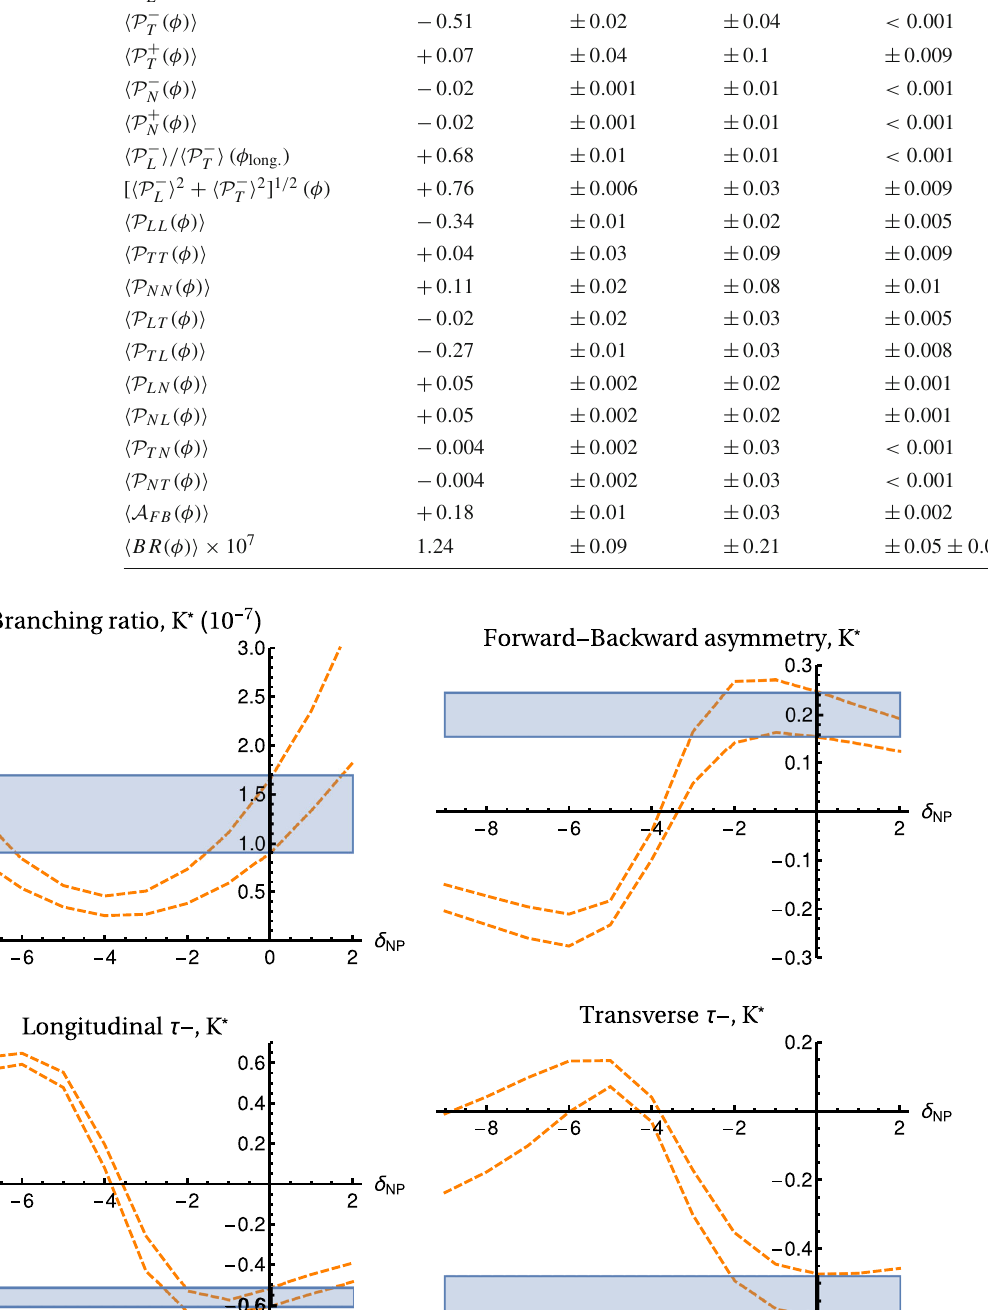
pendent on the value of δ NP ) and in the NP under consideration (dashed orange). The blue band corresponds to the errors seen in Table 3, which are recalculated for NP. See Fig. 7 for plots concerning B → K τ + τ